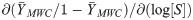
Successful application of the three-equation system (TES) strategy in the case of evolutionary variations in hemoglobin.(A) Correlation plot relating the values of nH for the 13 different mammalian hemoglobins of the physiologically-sound solution set derived either using the Hill equation (as reported in ref. [33]) or calculated according to the MWC model, based on L, KR and KT values (Table 1, red columns). Values for the human and elephant species correspond to the averaged values of three independent triplicates. (B) The same analysis but for the non-physiological solution set (Table 1, rightmost black columns). The expression for nH in terms of the L, KR and KT model parameters is known and can be obtained using the ∂(Y¯MWC/1−Y¯MWC)/∂(log[S]) Hill transformation (see Eq 4 and Methods).